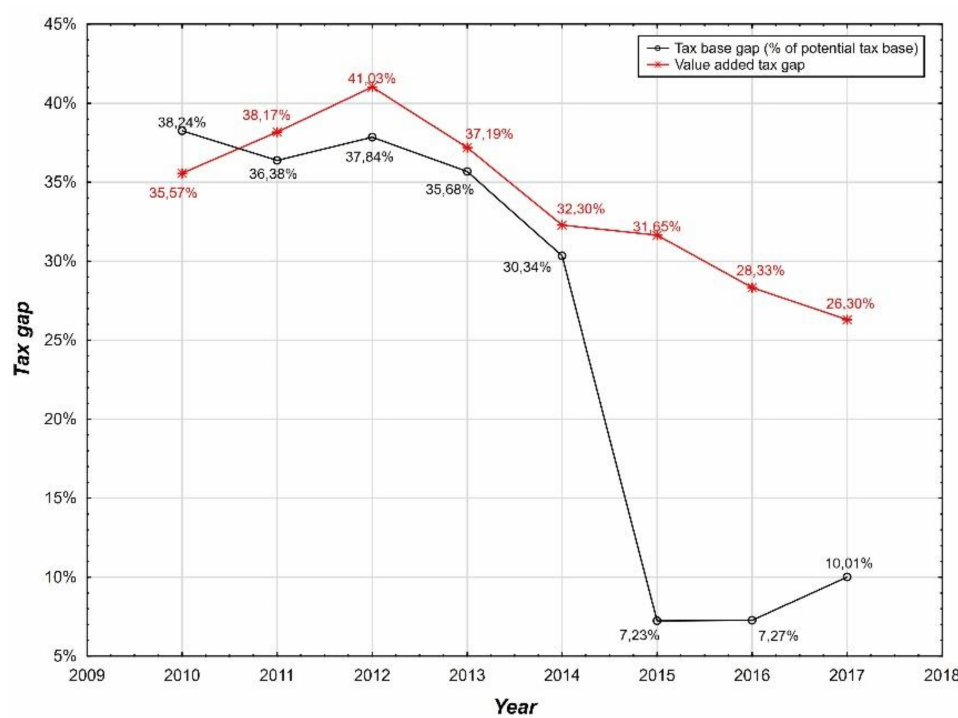
Figure 6. The tax gap on corporate income tax and VAT of legal